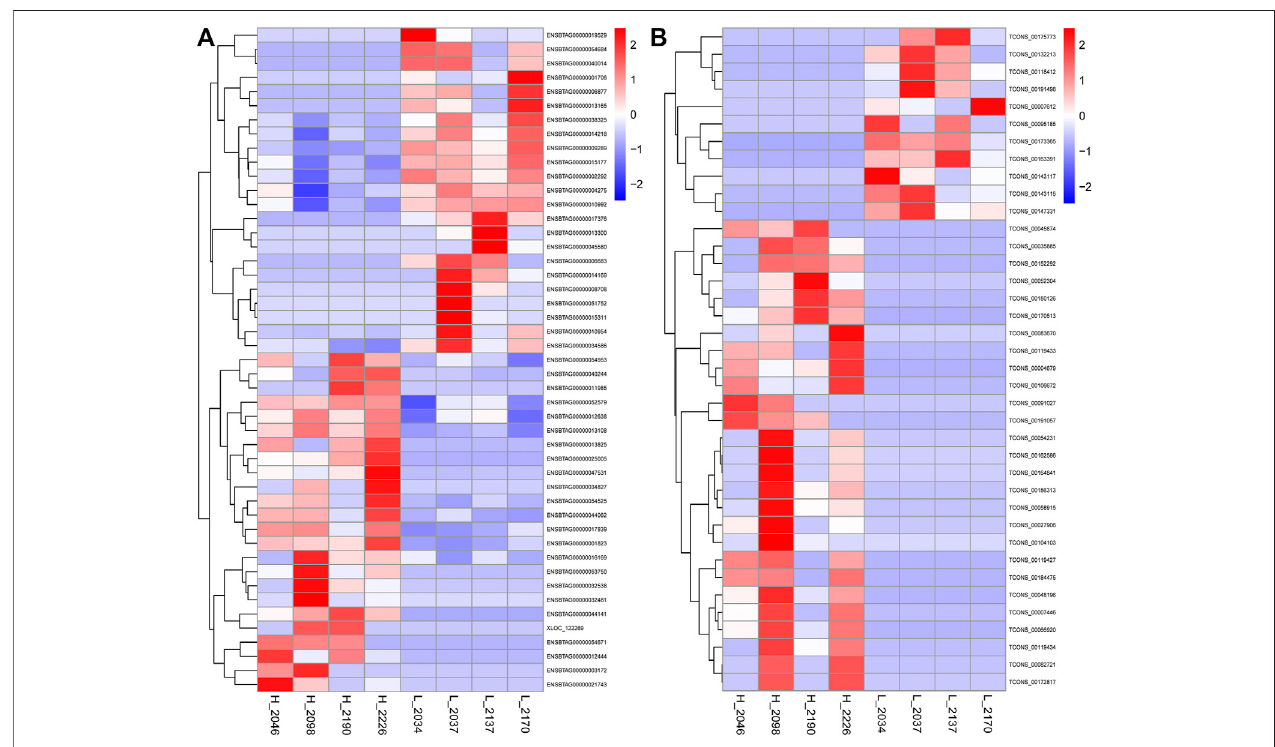
FIGURE4| HierarchicalclusteringofDEGsandDELs. (A) :TheDEGsclusteringheatmap,theabscissaisthesample,theordinateistheDEGs,theleftsideclusters the genes according to the degree of similarity of expression, the expression is gradually upregulated from blue to red, and the number is the relative expression after homogenization. (B) : The DELs clustering heat map.